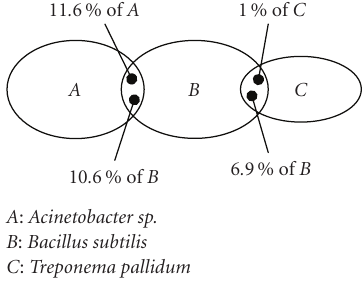
Figure 1: Concept of mixed pair: the mixed pair between A and B is truly mixed (IoM = ML and LoM = Phylum). The mixed pair between B and C is not truly mixed because n ( B ∩ C | C ) /n ( C ) < 5%.